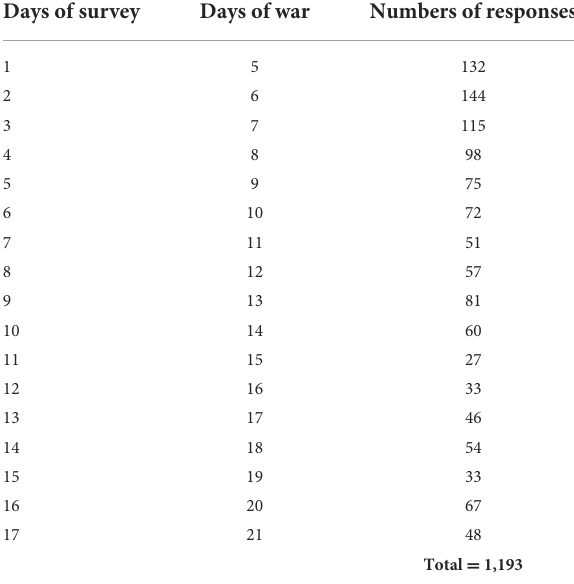
TABLE 2 The timing of this survey according with Russia-Ukraine war